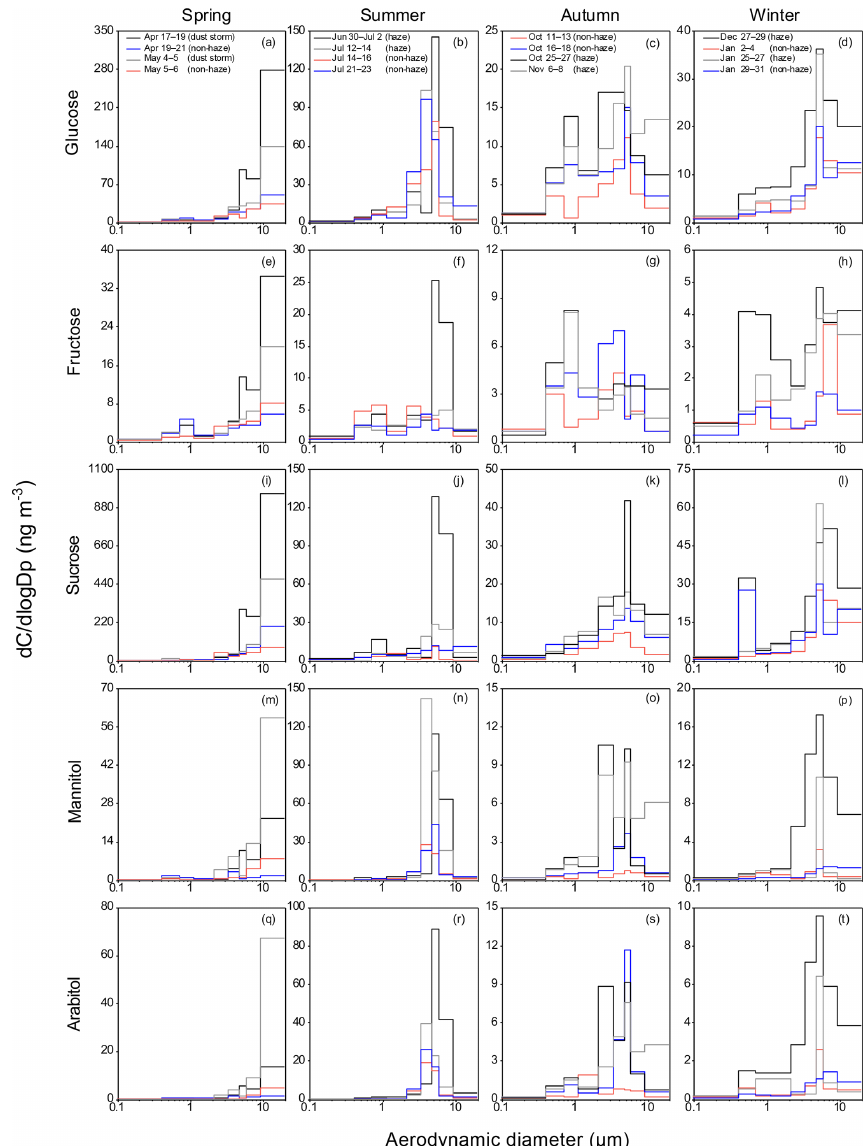
Figure 6. Size distributions of glucose, fructose, sucrose, mannitol and arabitol in urban aerosols in